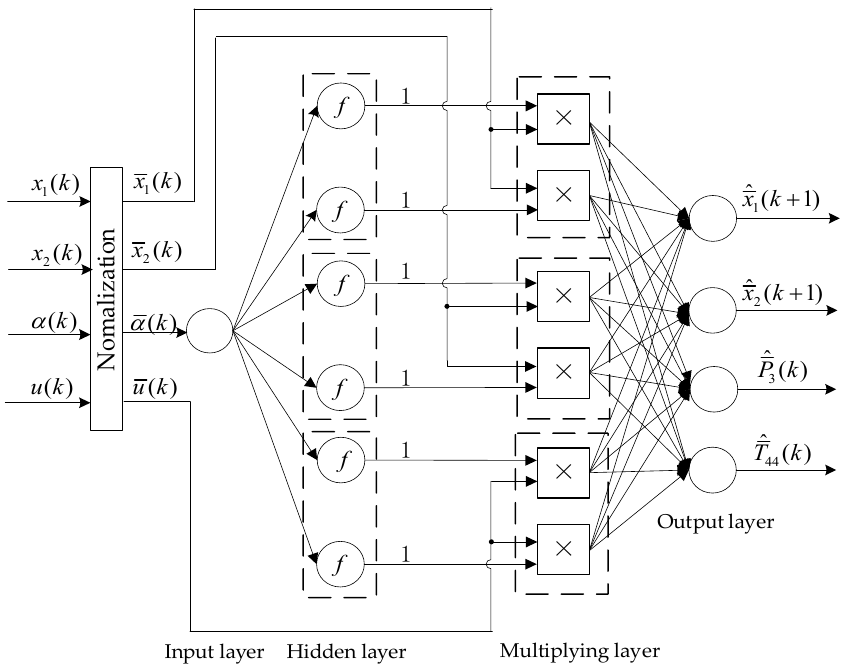
Figure 2. MLOS-ELM structure for DD-LPV modeling of the turbo-shaft engine. There were one-to-one local connections between the hidden layer and the multiplying layer, whose weight was set to 1. The nodes of the hidden layer were divided into 3